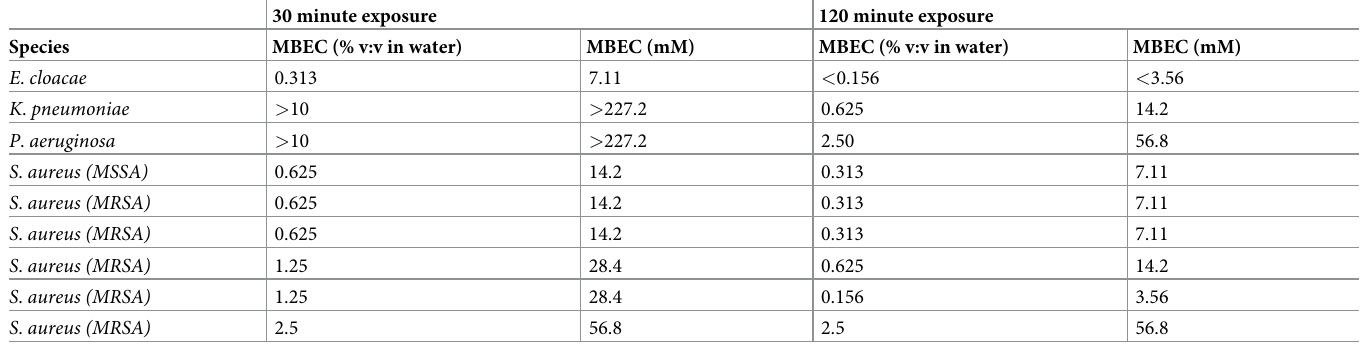
Table 1. Observed minimal biofilm eradication concentrations (MBEC) for 30 and 120 minute exposures of dilute CAGE against 24 hour old biofilms of selected ESKAPE pathogens. Each MBEC value represents the largest of three (n = 3) independent measurements.